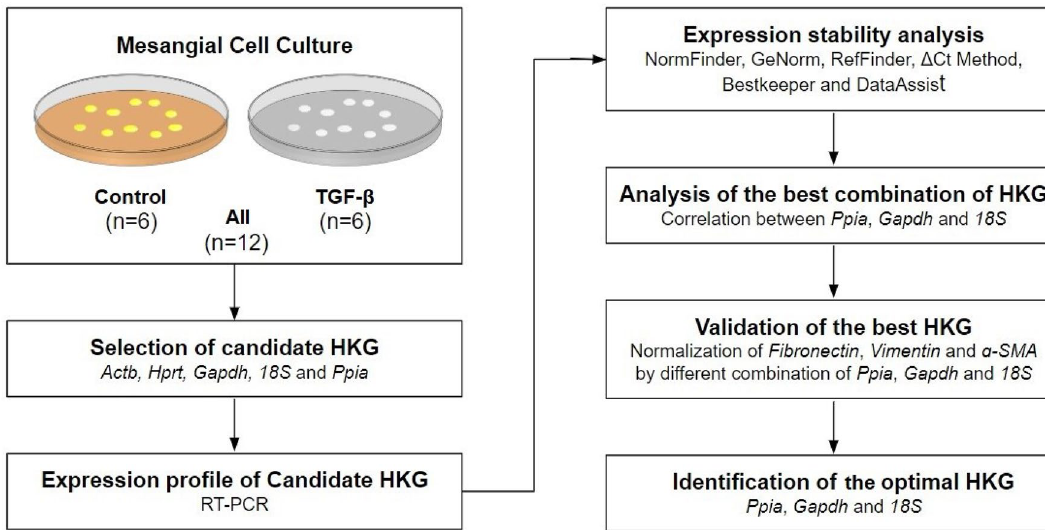
Figure 1. Workflow diagram illustrating the strategy for identification of housekeeping normalizer for RT-PCR. Actb, Hprt, Gapdh, 18S and Ppia housekeeping genes (HKG) selected from the literature for